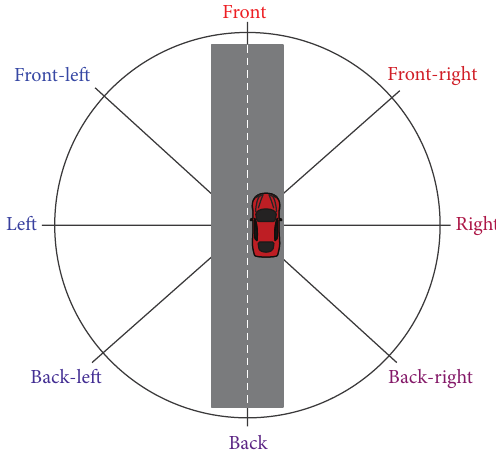
Figure 11: Eight exemplary satellite positions relative to the street orientation, which are further